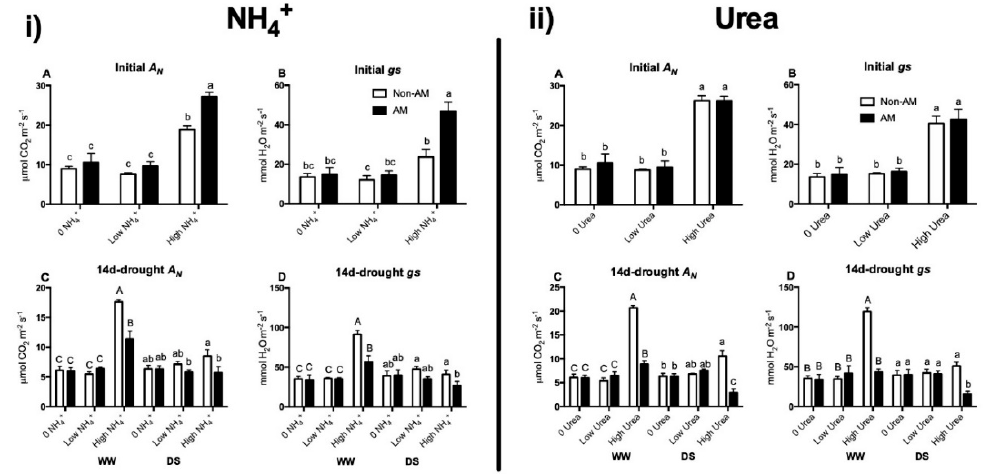
Figure 4. Net photosynthesis ( A N ) and stomatal conductance ( gs ) in maize plants inoculated or not with the AM fungus Rhizophagus irregularis (AM), submitted to two water regimes (well-watered, WW or drought stress, DS for 14 days) and grown under di ff erent urea or ammonium concentrations (0 N added; low N, 3 µ M or high N, 10 mM). Parameters were measured before stress treatment (Initial values) (( i ) A ) and (( i ) B ) for NH 4 + experiment and (( ii ) A ) and (( ii ) B ) for the urea experiment) or 14 days after starting the drought stress treatment (14d-drought) (( i ) C and (( i ) D for NH 4 + experiment and (( ii ) C ) and (( ii ) D ) for the urea experiment). Data represents the means of five biological replicates ± SE. Di ff erent letter (uppercase for WW treatments and lowercase for DS treatments) indicates significant di ff erences between treatments ( p < 0.05) based on Duncan’s test.